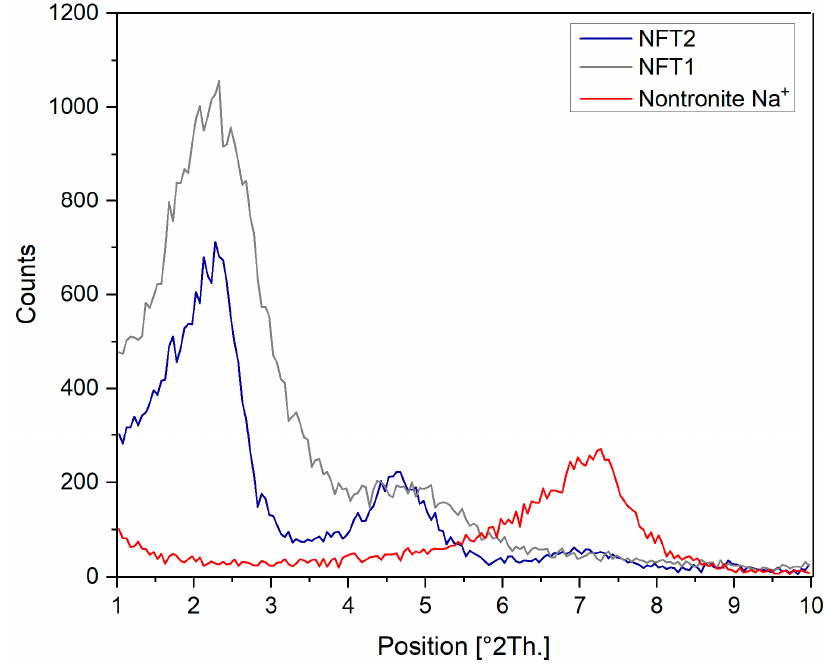
Figure 9. Diffractograms of Nontronite Na + and organoclays NFT1 and NFT2.